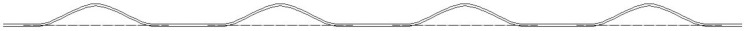
The shape of pipeline with multiple initial imperfections.